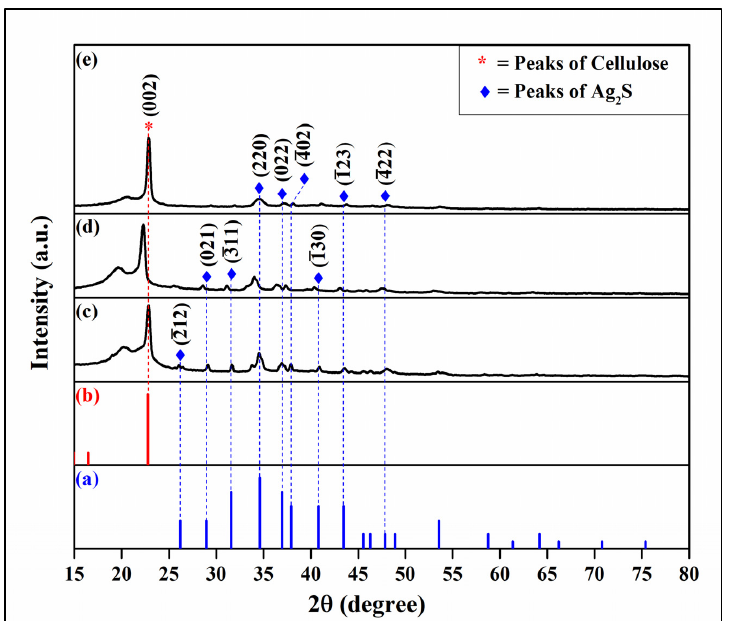
Figure 5. X-ray diffraction spectra of: ( a ) database of Ag 2 S (ICDD No. 00-009-0422), ( b ) database of cellulose (ICDD No. 00-050-2241), ( c ) CF/syntAg 2 S1, ( d ) CF/syntAg 2 S2, and ( e ) CF/syntAg 2 S3.